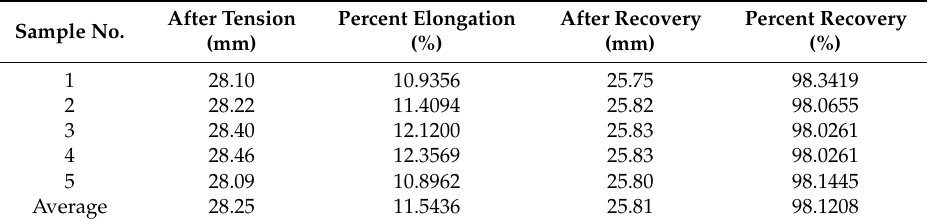
Table A4. DM8510.